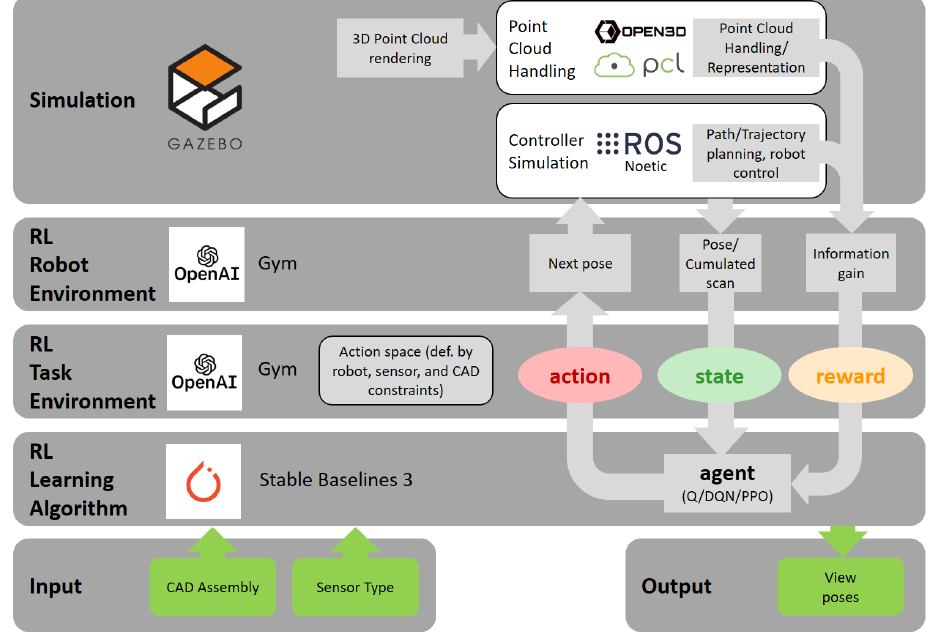
Figure 2. The framework architecture separated by application layer. Each instance of a layer inherits its upper layer and displays a one-to-many relationship, e.g., multiple RL task environments descend from a robot environment.